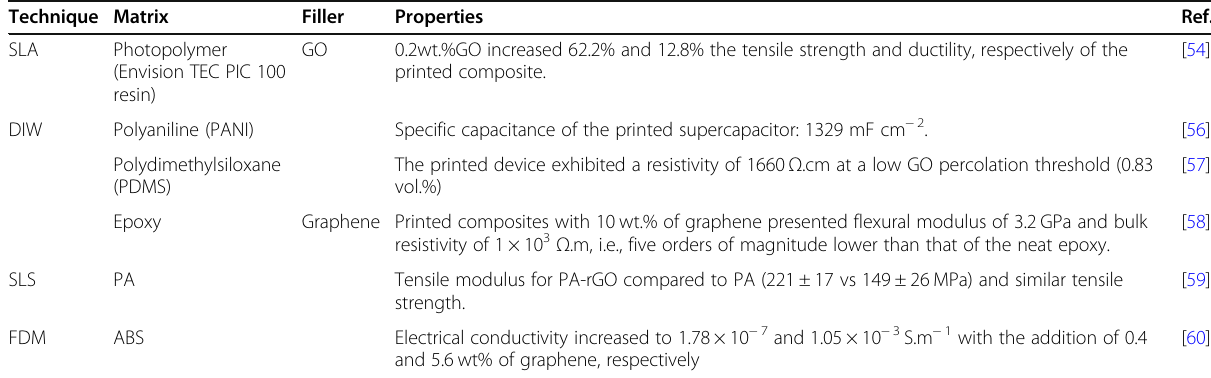
Table 4 Properties of 3D printed graphene-based composites Technique Matrix